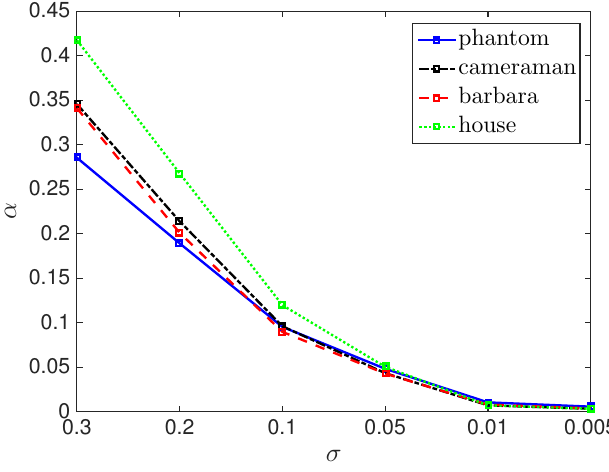
Figure 4. Regularization parameter versus noise-level for the box-constrained pAPS in image denoising.